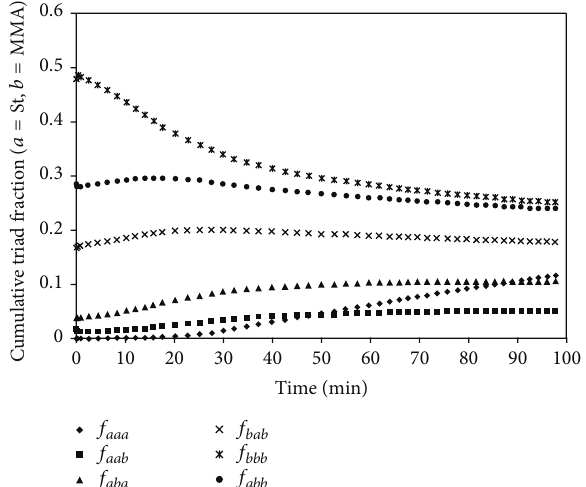
Figure 6: Cumulative triad fraction as a function of polymerization time for MMA-St copolymer. The initial monomers molar ratios are = 0.90 and 𝑓 = 0.10 . The full modeling parameters are 𝑓 0, MMA 0, st available in